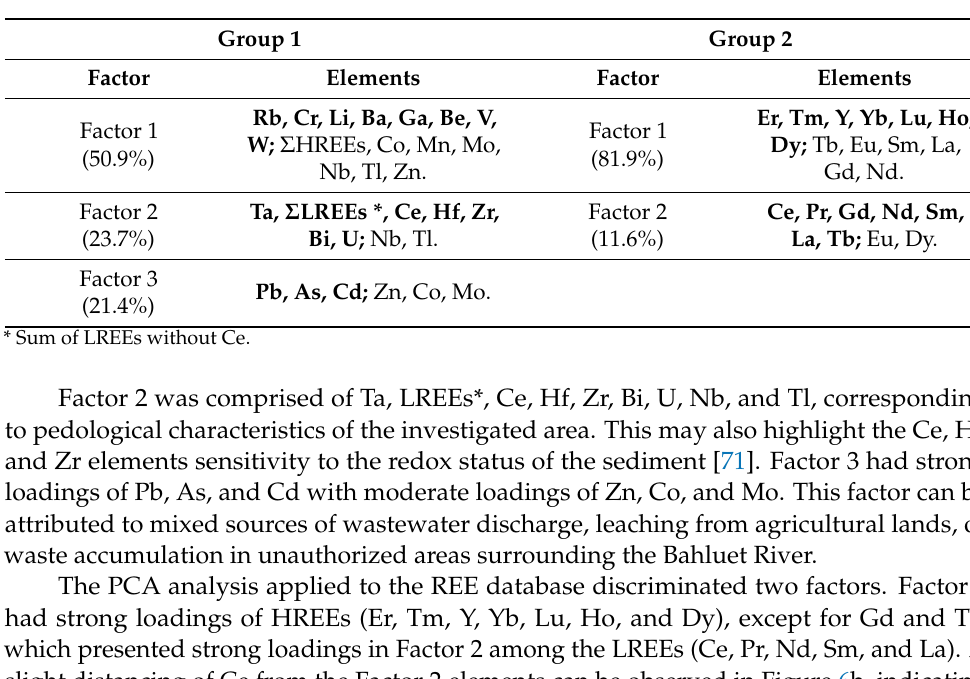
Table 3. Distribution of the elements in the factors extracted according to PCA for loadings > 0.50, loadings > 0.75 in bold, and the total variance (%) explained by each factor. Group 1 Group 2 Factor Elements Factor Elements Rb, Cr, Li, Ba, Ga, Be, V, Factor 1 W; Σ HREEs, Co, Mn, Mo, (50.9%) Nb, Tl, Zn. Ta, Σ LREEs *, Ce, Hf, Zr, Factor 2 Bi, U; Nb, Tl. (23.7%) Factor 3